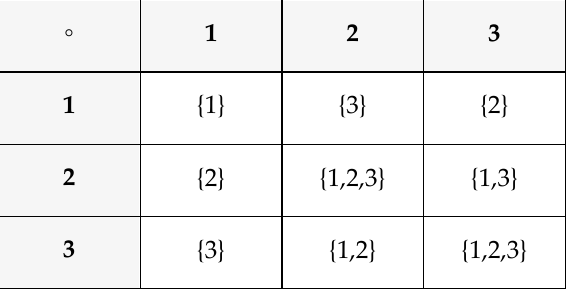
Table 18. Right almost-hypergroup with right scalar